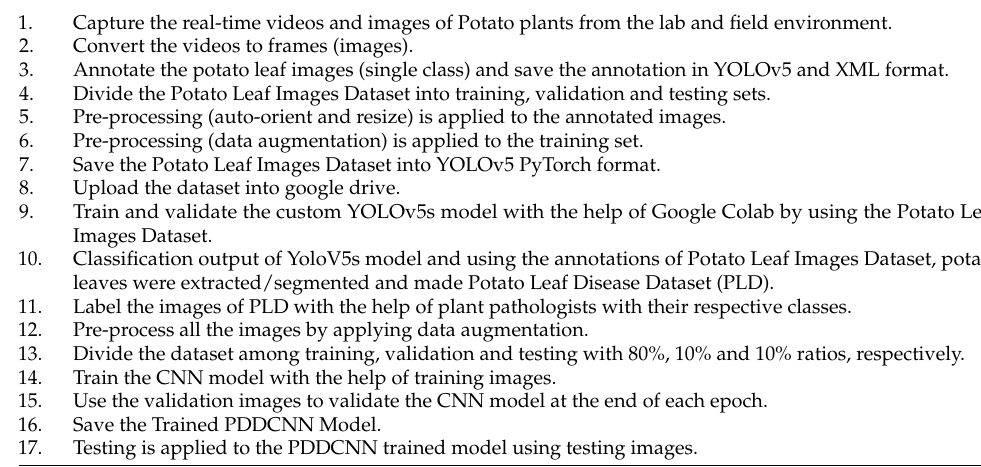
Algorithm 1 Multi-Level Deep Learning Model for Potato Leaf Disease Recognition